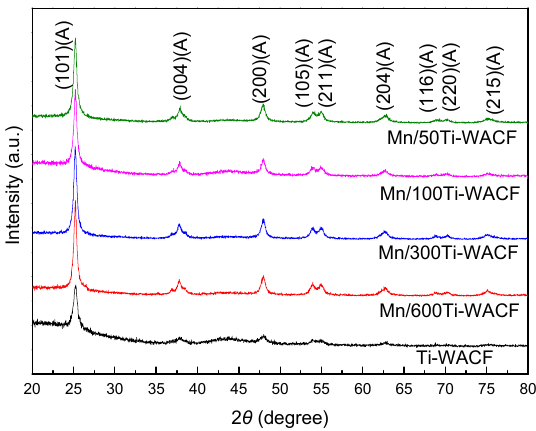
Figure 2. XRD diffractograms of loaded materials with different Mn doping concentrations.